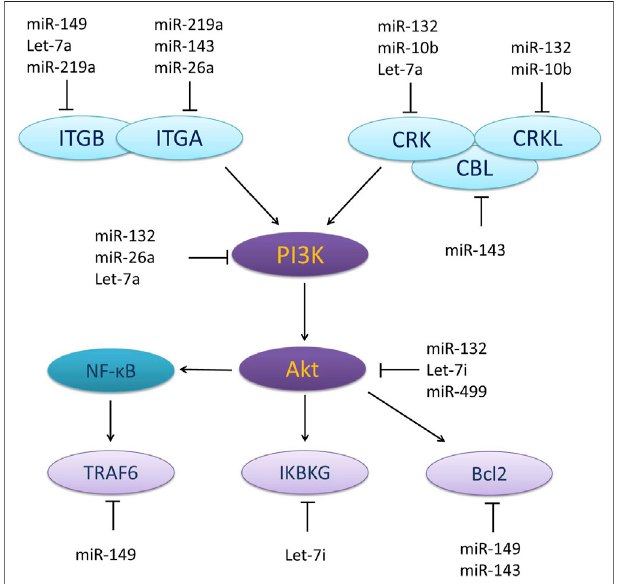
FIGURE 1 | Nine miRNAs involving in PI3K/Akt signalling pathway.